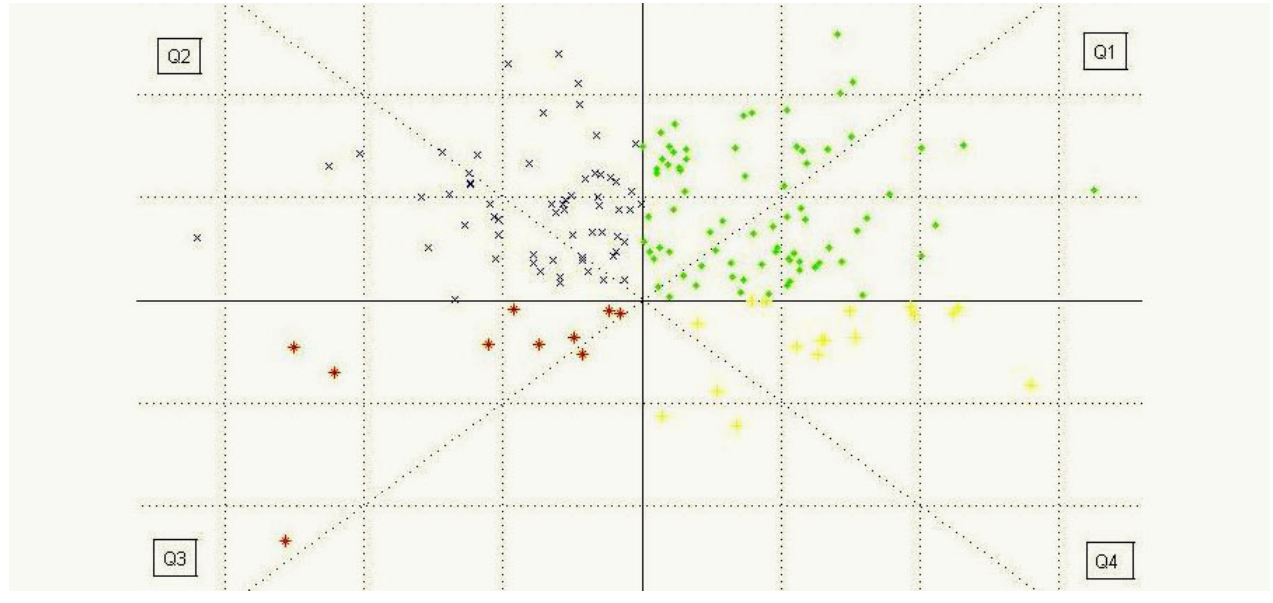
Fig. 1. Log of relative change in yield (dY) and log of relative change in cultivated area (dA) on the y and x axis, respectively, both at national level, for 173 countries (dP » dY + dA). Q1 holds “growth” countries, Q2 “intensifying” countries, Q3 “decline” countries, and Q4 “expansion” countries (see Methods: Between groups